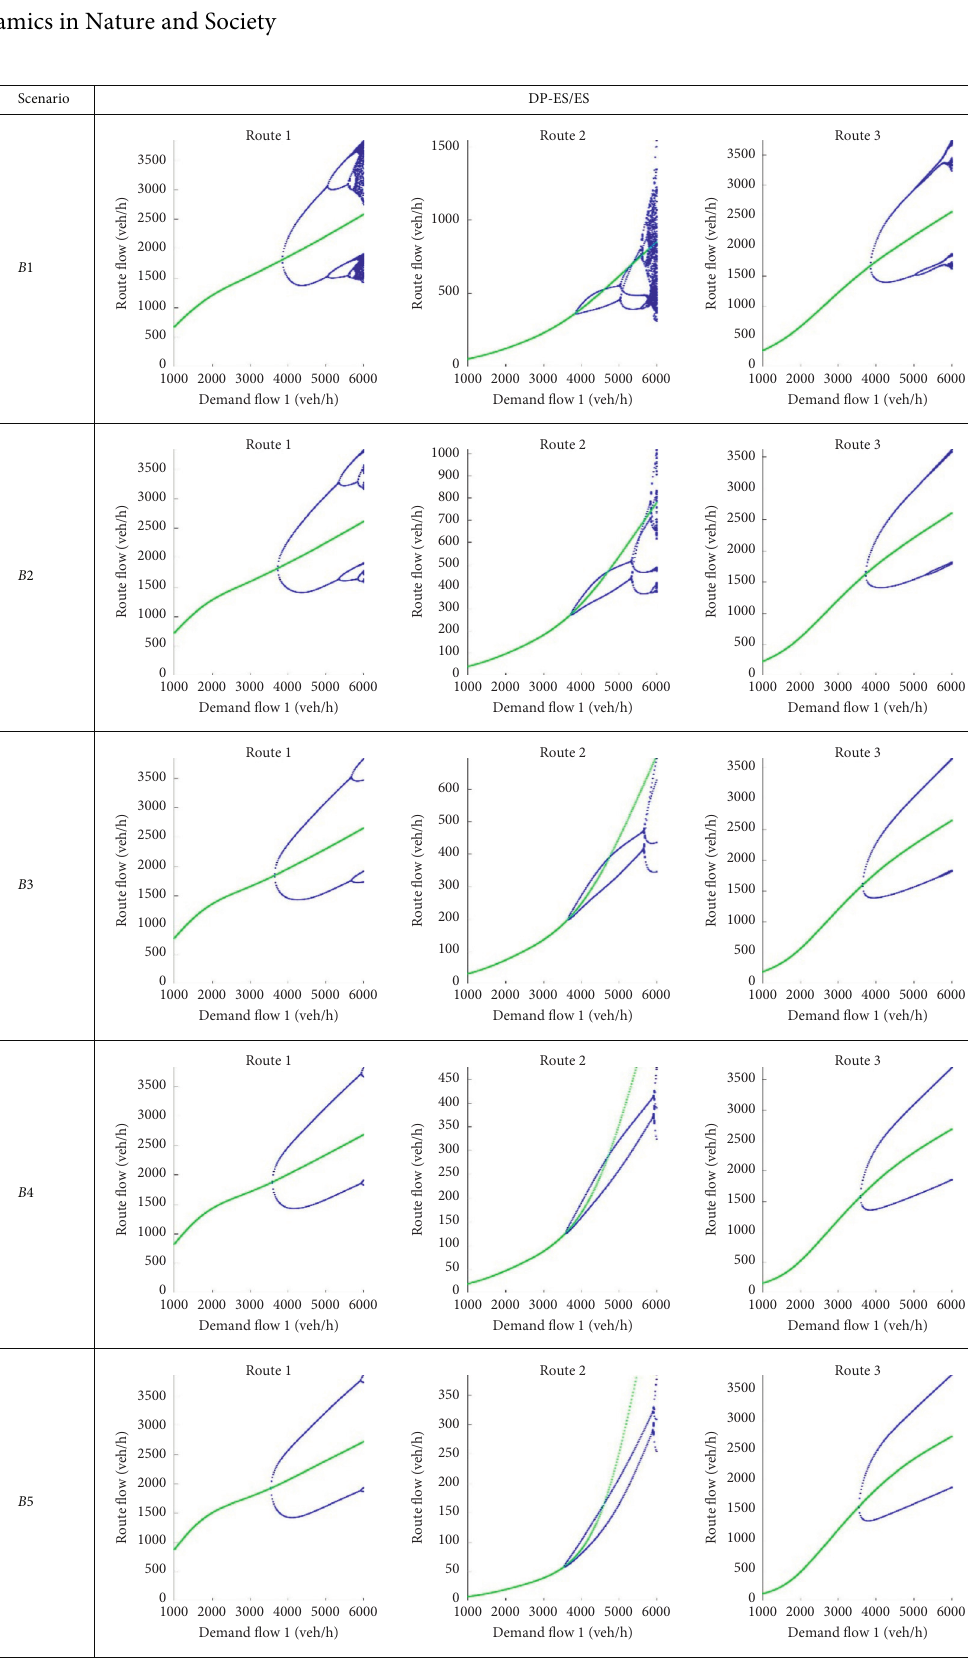
� 7.0 and θ � TV AV